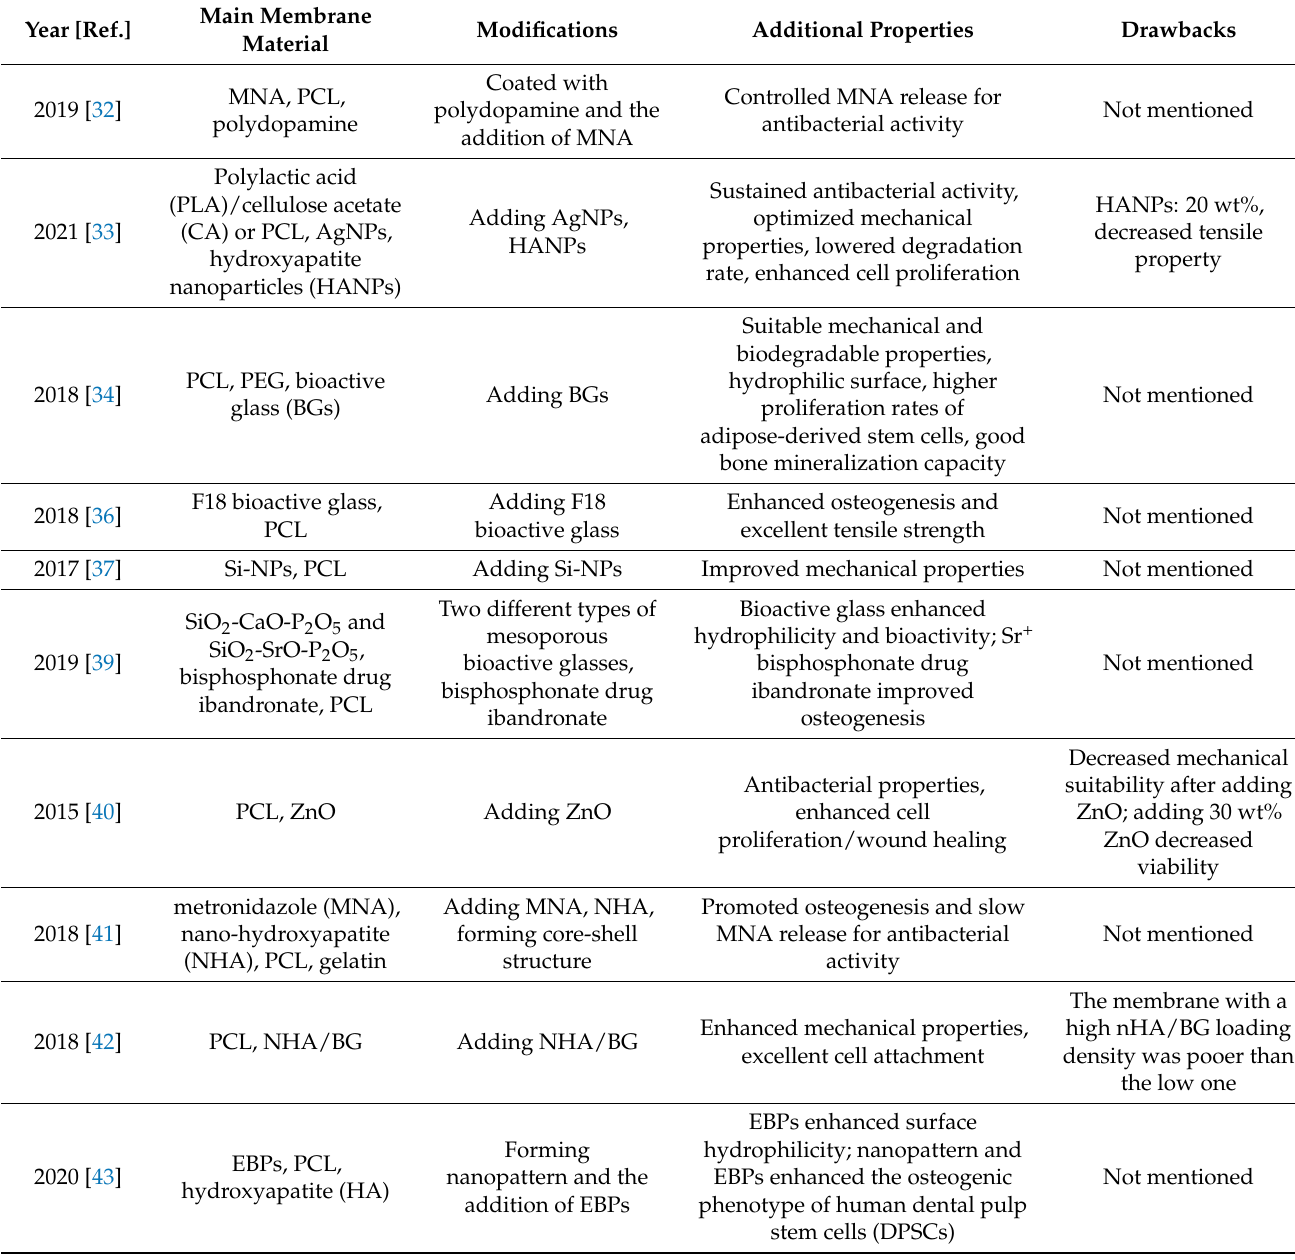
Table 1. The various properties of modified PCL